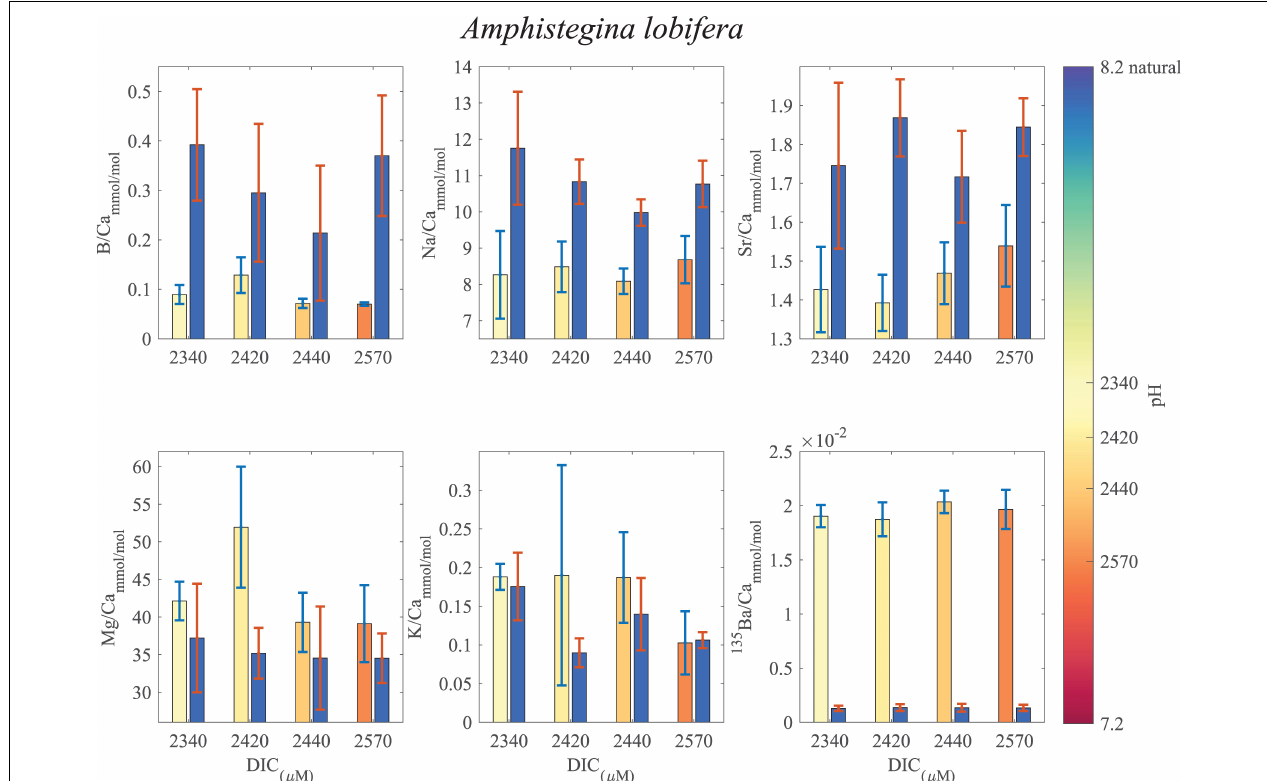
FIGURE 7 | Averages of El/Ca ratios of the natural-original shells of Amphistegina lobifera in comparison with the newly grown shell under the DIC modified experimental conditions. For B/Ca, Na/Ca and Sr/Ca the new shell ratios are significantly lower than the original shell. For K/Ca and Mg/Ca the new shells show ratios that are significantly higher than the original shell (see Tables 1 , 2 for statistics). 135 Ba/Ca show the enrichment of the 135 Ba that was added to the culture media to mark the newly precipitated calcite. The numbers on the colored pH bar represent the experimental average DIC measurements during the